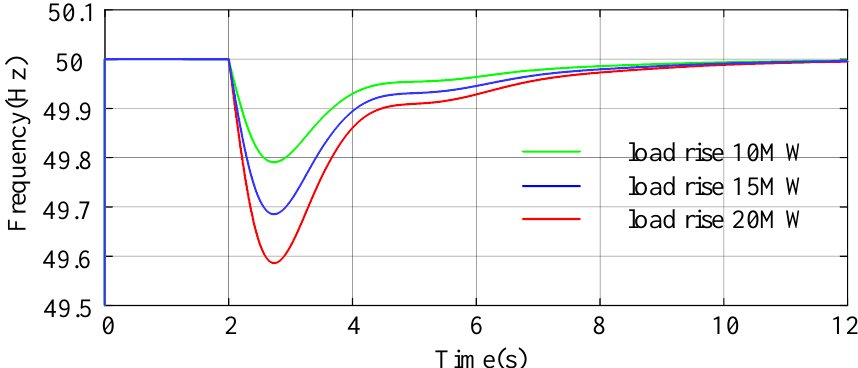
Figure 19. System frequency regulation result of medium wind speed.